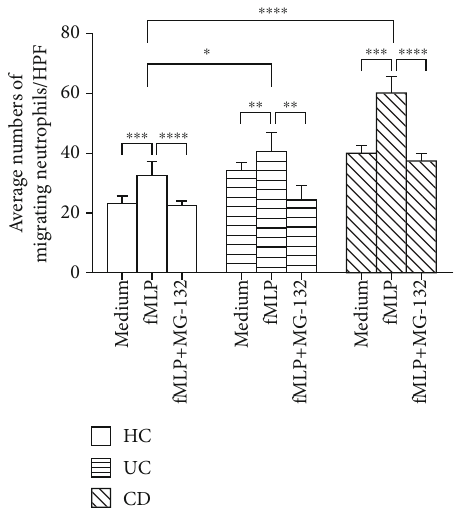
Figure 6: MCPIP-1 suppresses the migration of neutrophils. Peripheral neutrophils ( 5 × 10 5 ) were isolated from HC ( n = 10 ), active CD ( n = 10 ) and active UC ( n = 10 ) patients and measured with an 8 μ m Transwell plate under attraction with fMLP (50 nM) in the absence or presence of MG-132 (20 μ M) for 3 hours. The histogram represents the number of migrating neutrophils per high-power fi eld (HPF). ∗∗ P < 0 : 01 , ∗∗∗ P < 0 : 001 , and ∗∗∗∗ P < 0 : 0001